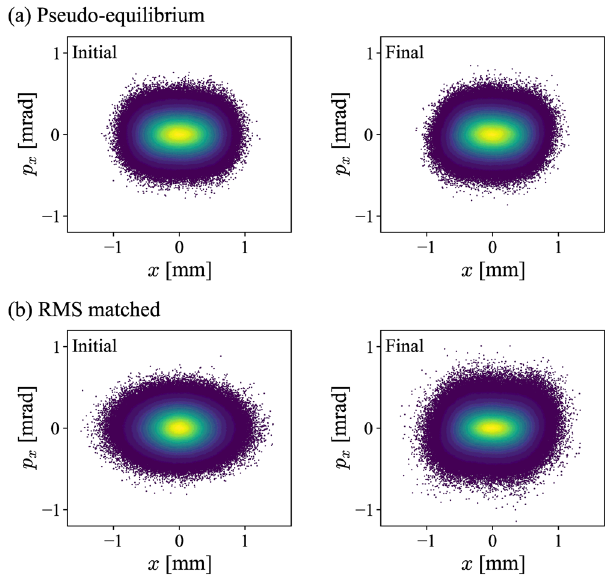
FIG. 14. Initial and final particle distributions in the horizontal phase space, corresponding to the W ARP simulations in Fig. 13. The transverse rms emittance has been assumed initially to be about 0 . 05 π mm · mrad. In the upper panel (a), the beam is initially in a pseudoequilibrium state while in the lower panel (b), rms matched to the lattice at injection.